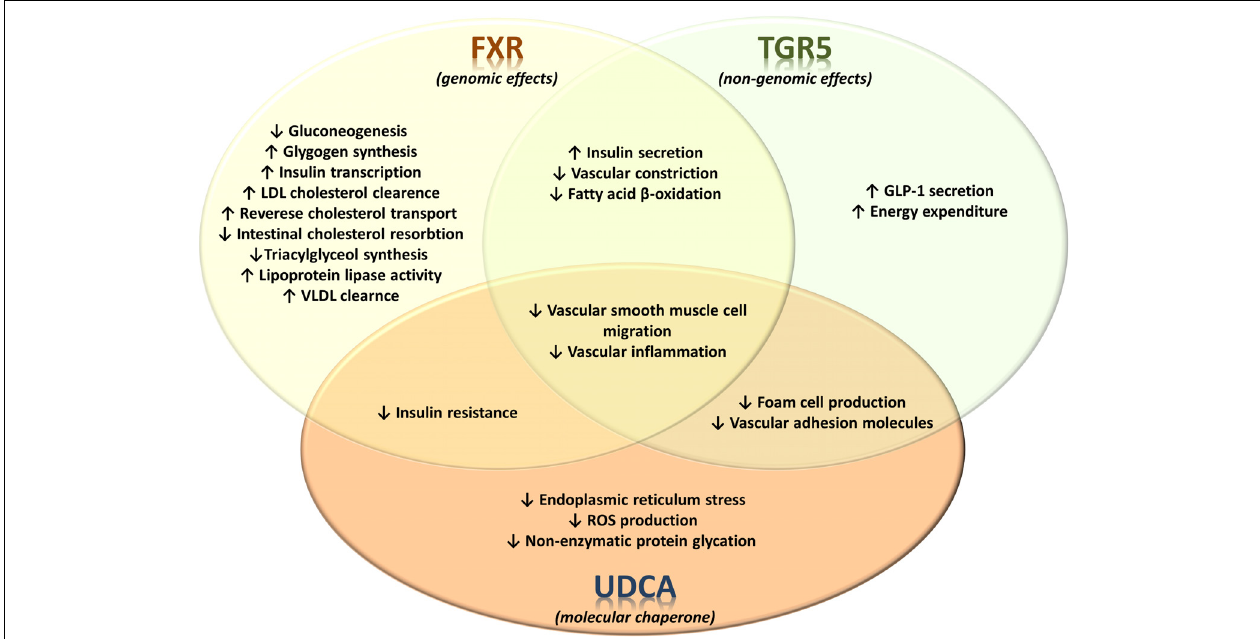
FIGURE 4 | Receptor-dependent and receptor-independent regulation of metabolic and signaling pathways by bile acids in metabolic syndrome. The effects of bile acid-activated receptors FXR and TGR5 on glucose, lipid and energy metabolism as well as on vascular events associated with atherosclerosis. FXR and TGR5 have significant number of currently identified overlapping effects. On the other hand, the effects of UDCA are not associated with activation of these bile acid receptors, instead UDCA exerts various physiological/pharmacological effects which are associated with its specific structural